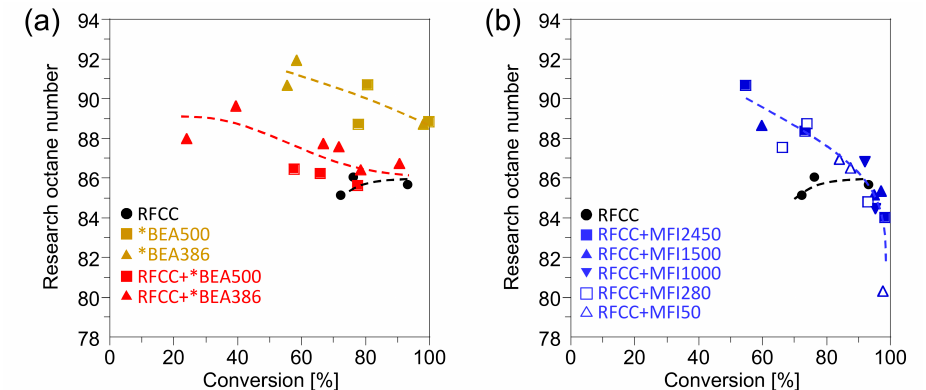
Figure 6. Research octane number of the gasoline fraction. ( a ) Reaction product on the *BEA catalyst and the composite catalyst with the *BEA zeolite. ( b ) Reaction product on the composite catalyst with the MFI